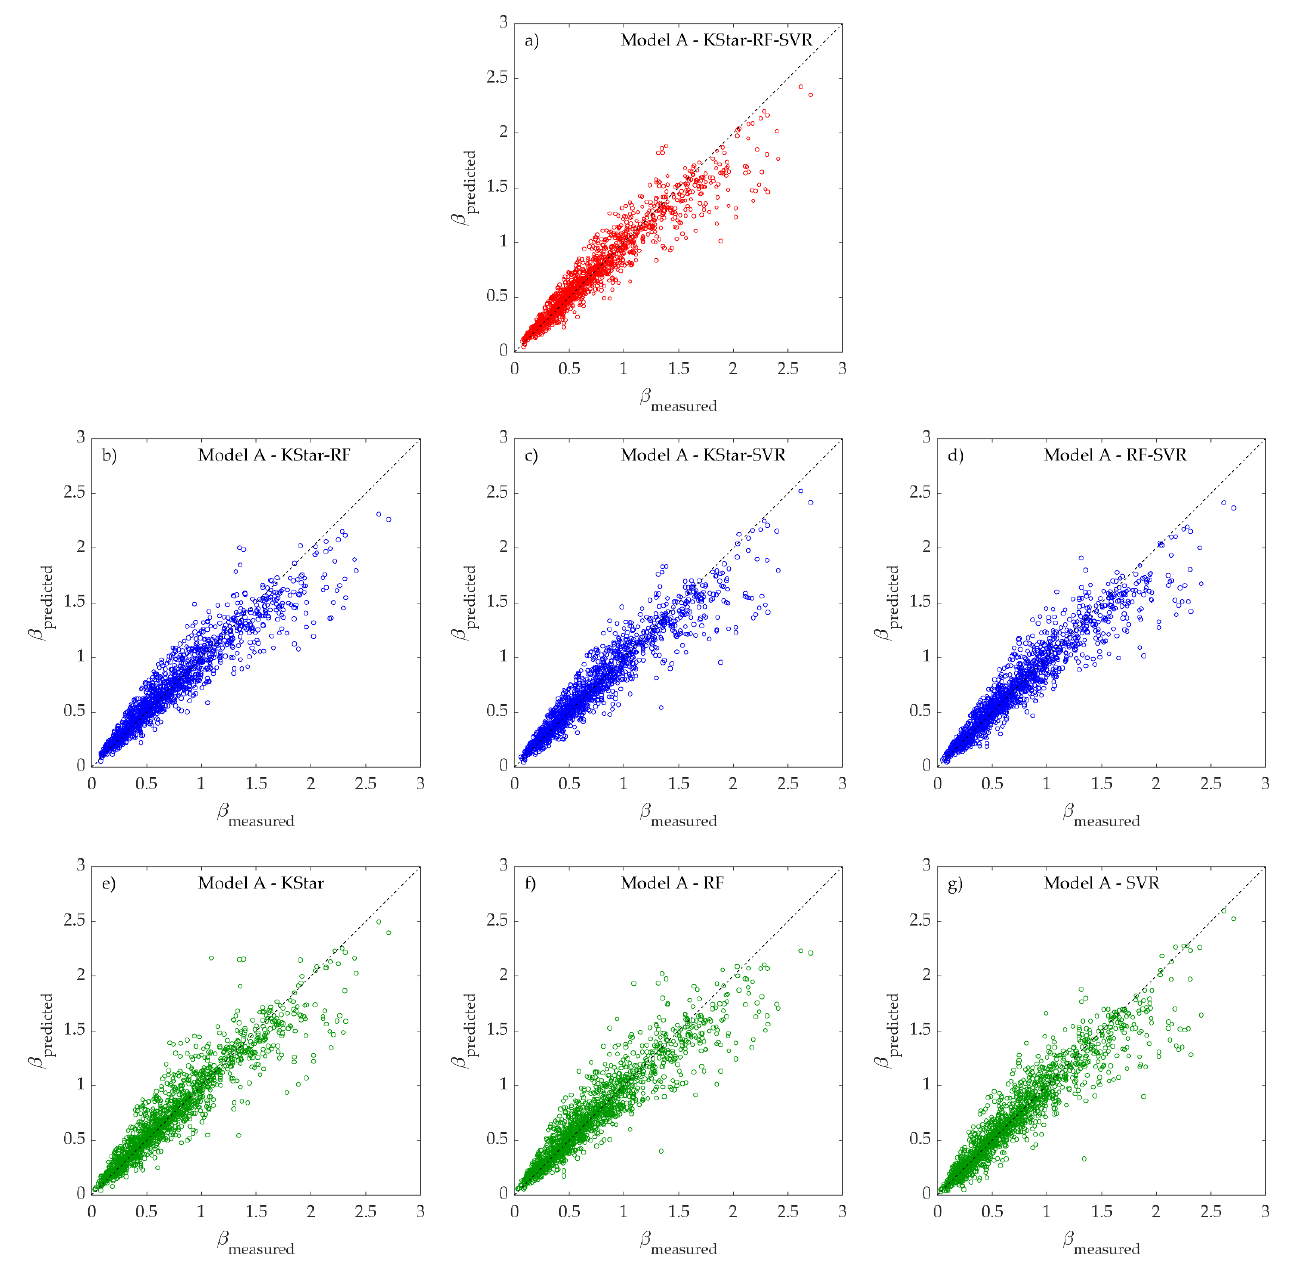
Figure 6. Model A: b predicted versus b measured.